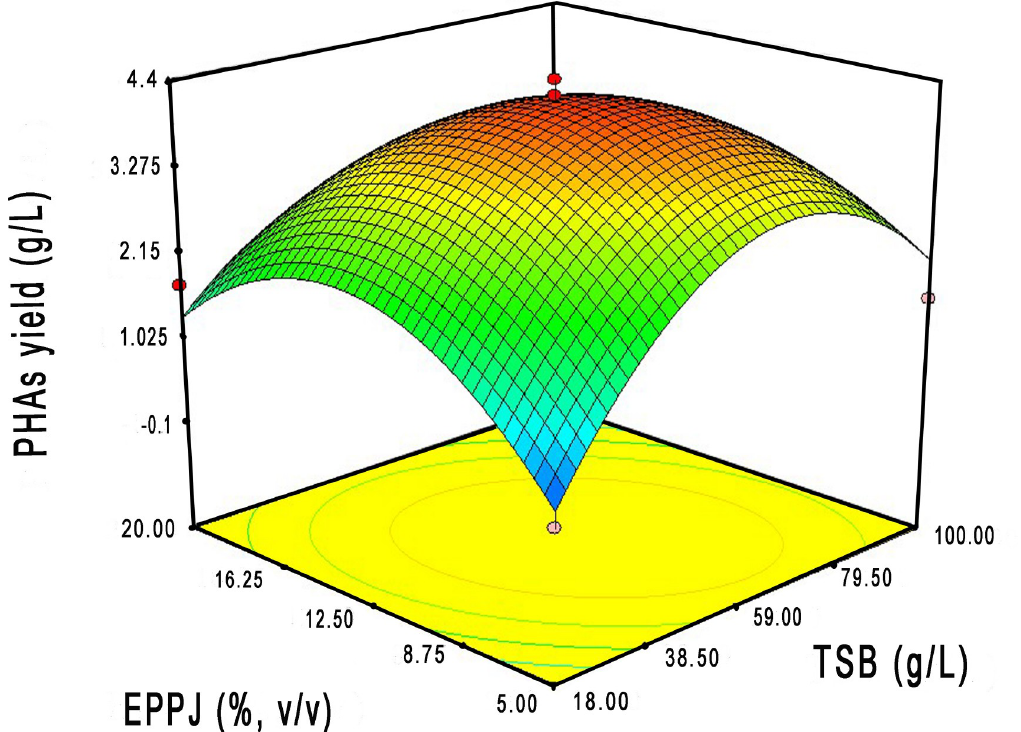
Fig 3. Response surface plot and contour showing the effect of TSB medium and extracted pineapple peel juice (EPPJ) on the PHAs production by Bacillus drentensis BP17.